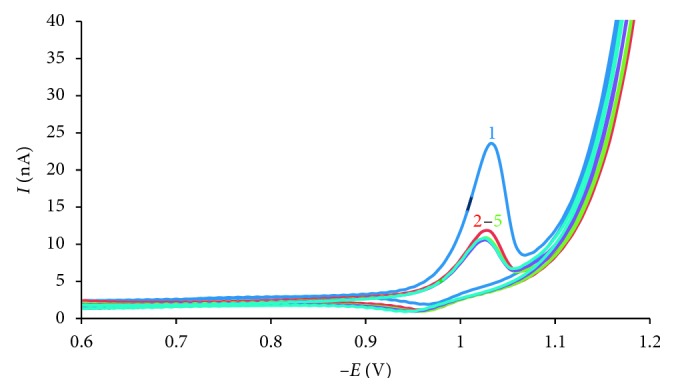
Cyclic voltammogram at scan rate 50 mV·s−1 and Eacc = 0 V for 10−6 mol·L−1 AO solution with tacc = 30 s (1); (2–5) repetitive cyclic of (1) at the same mercury drop.